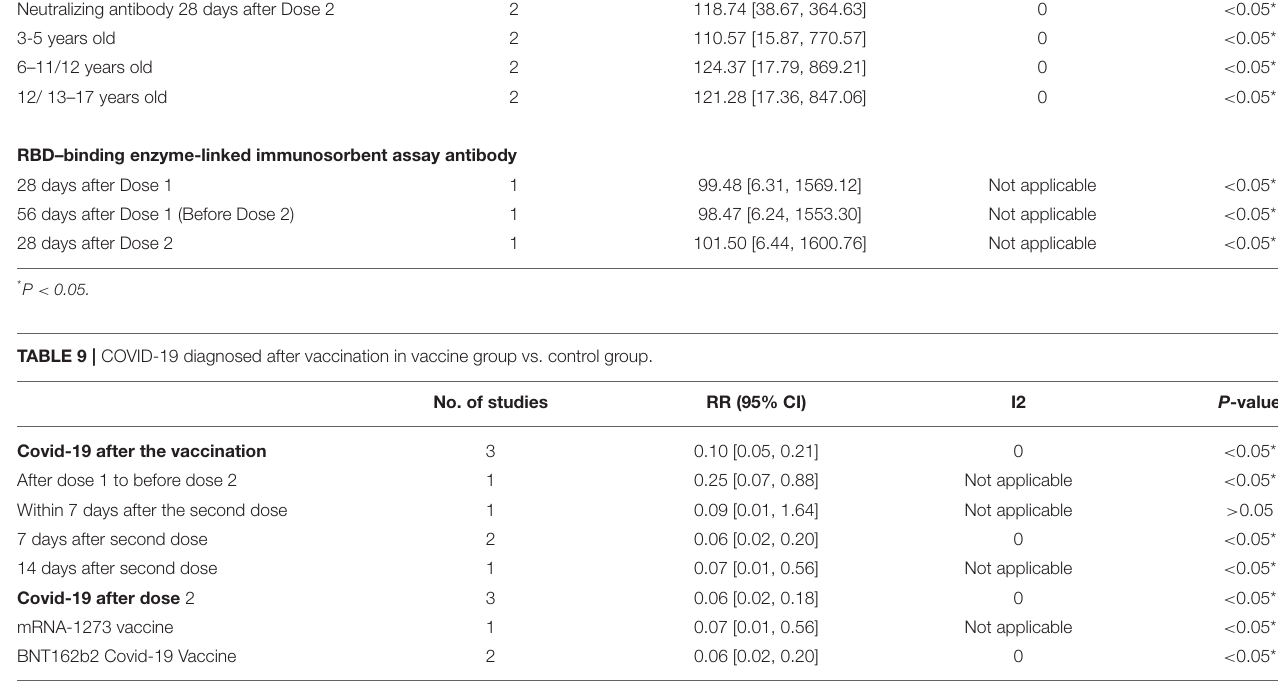
RBD–binding enzyme-linked immunosorbent assay antibody